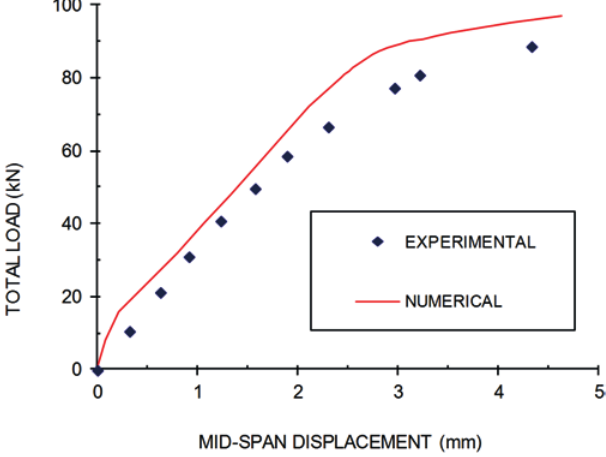
Figura 14 Comparison between numerical (ANEST/CA) and experimental results for frame A60 tested by Ernst et al.